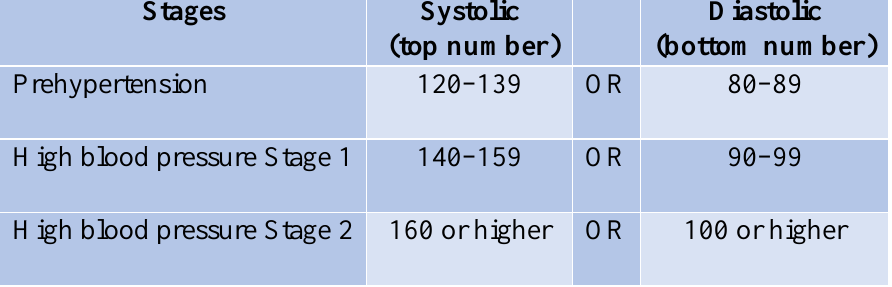
Table 1 . Defined stages of high blood pressure in adults